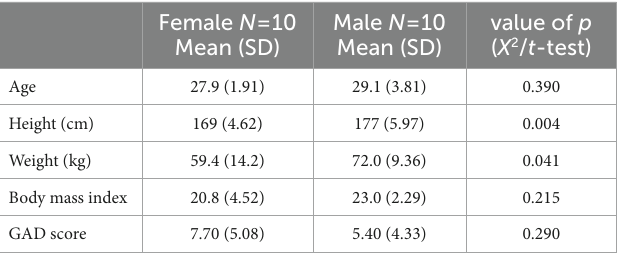
TABLE 1 Participant characteristics according to gender.